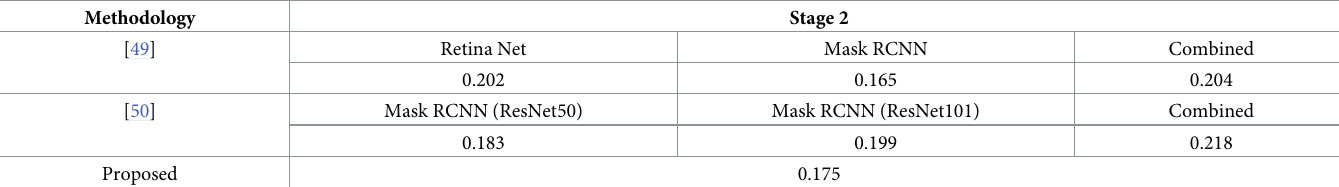
Table 8. Comparison of proposed methodology with existing techniques on RSNA dataset.